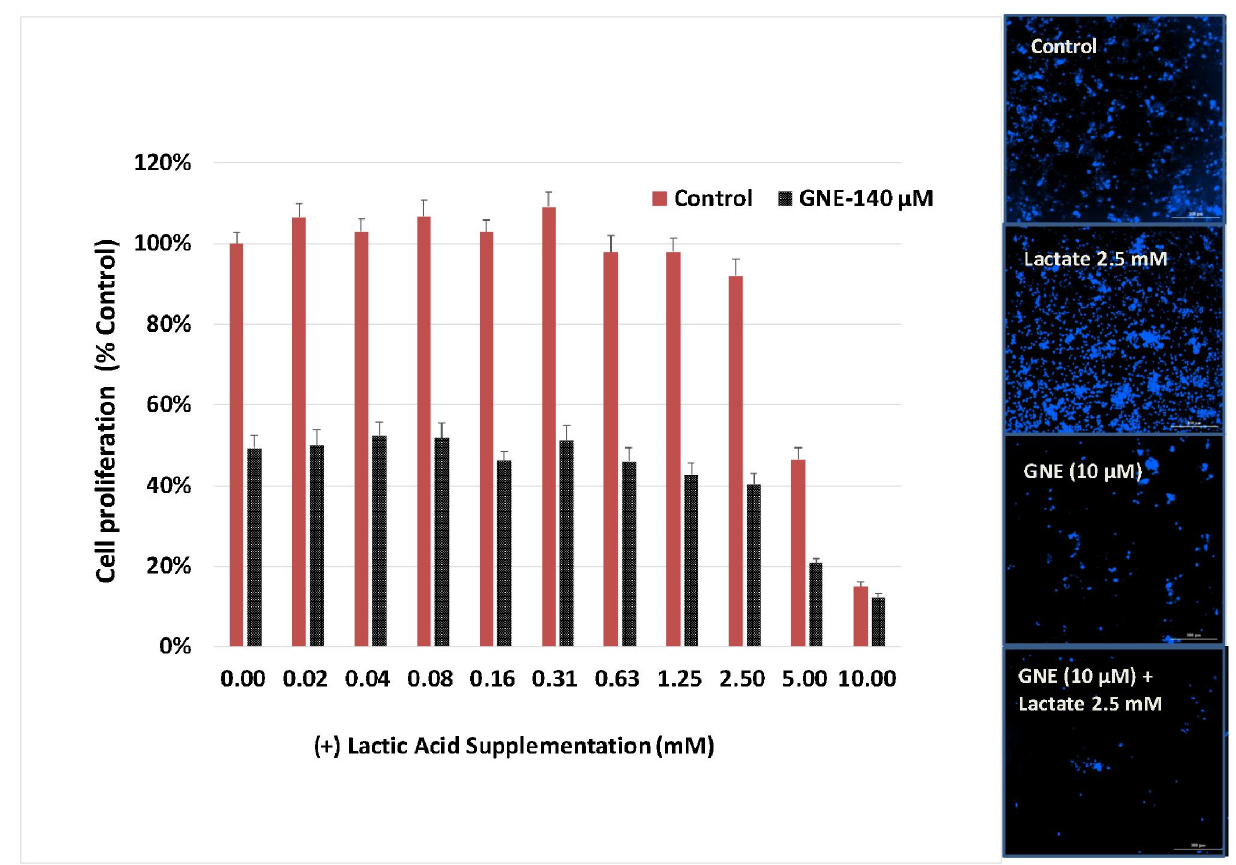
Figure 5. Non-reversible cytostatic effects of GNE-140 at 7 days in the presence or absence of exogenous supplemented (+) lactic acid in the media. The data represent cell proliferation and are expressed as % untreated controls, with GNE-140 (10 µ M) held constant in combination with increasing concentration of (+) lactic acid. Viable cell count was measured using Alamar Blue (left panel) and images taken using DAPI nuclear staining (right panel). The data are expressed as the mean ± S.E.M, n = 4.